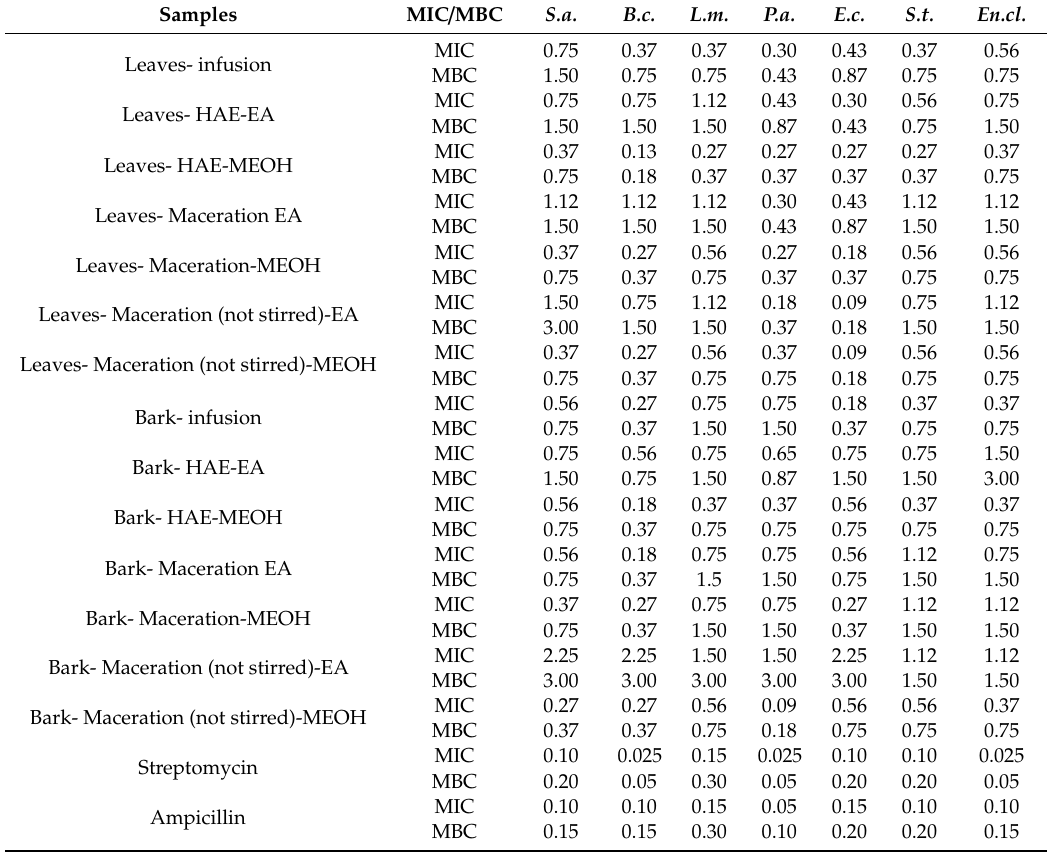
Table 5. Antibacterial activity of tested samples, results are in mg /